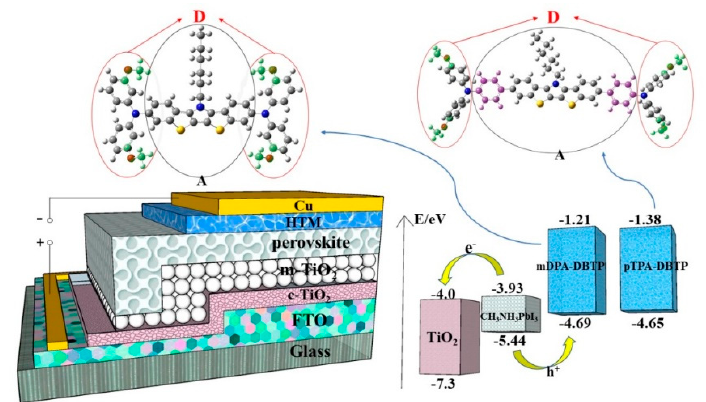
Figure 1. Chemical structures of the investigated molecules and energy level diagram, where FTO, A, D, e and h represent fluorinated tin oxide, acceptor, donor, electron and hole, respectively.